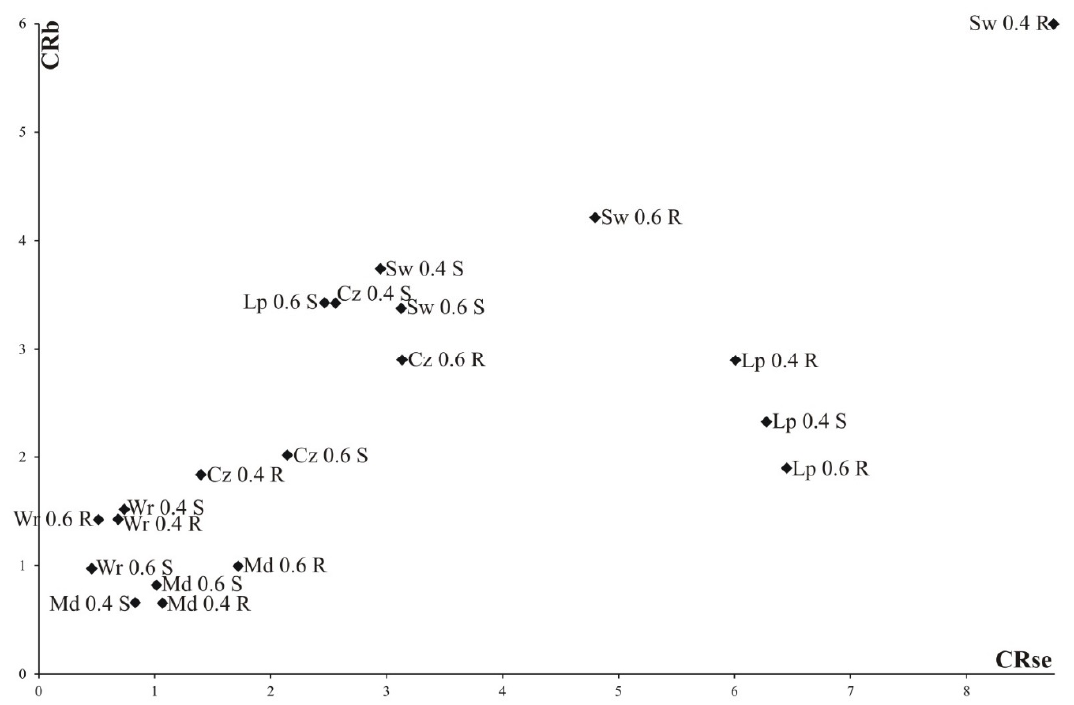
Figure 9. Relationships between relative biomass of plants (CRb) and the relative number of seeds (CRse) for the combinations of sites × winter wheat proportion in the mixture × cornflower biotypes, in 2018–2019. Legend: Cz—Czes ł awice, Lp—Lipniki, Md—Mydlniki, Sw—Swojczyce, WG—Winna Góra, Wr—Wroc ł aw (sites of experiments); R—cornflower biotype of resistant cornflower; S—susceptible biotype.